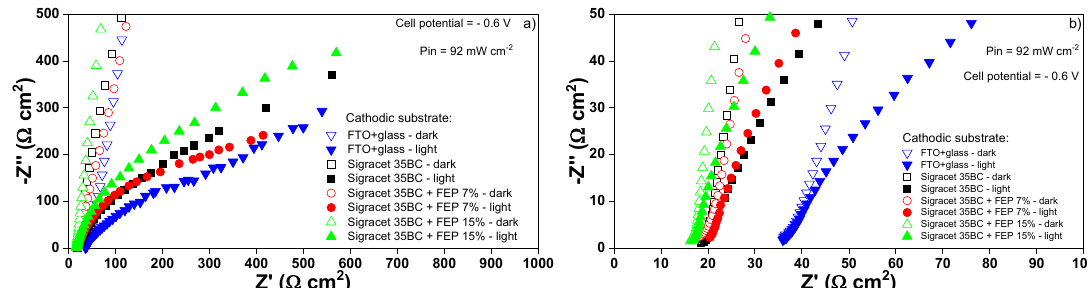
Figure 8. Electrochemical Impedance Spectroscopy of the PEC cell (glass + FTO + Fe 2 O 3 + NiFeO X + ionomer / FAA-3 / ionomer + CuO + cathodic substrate), for various photocathode substrates under